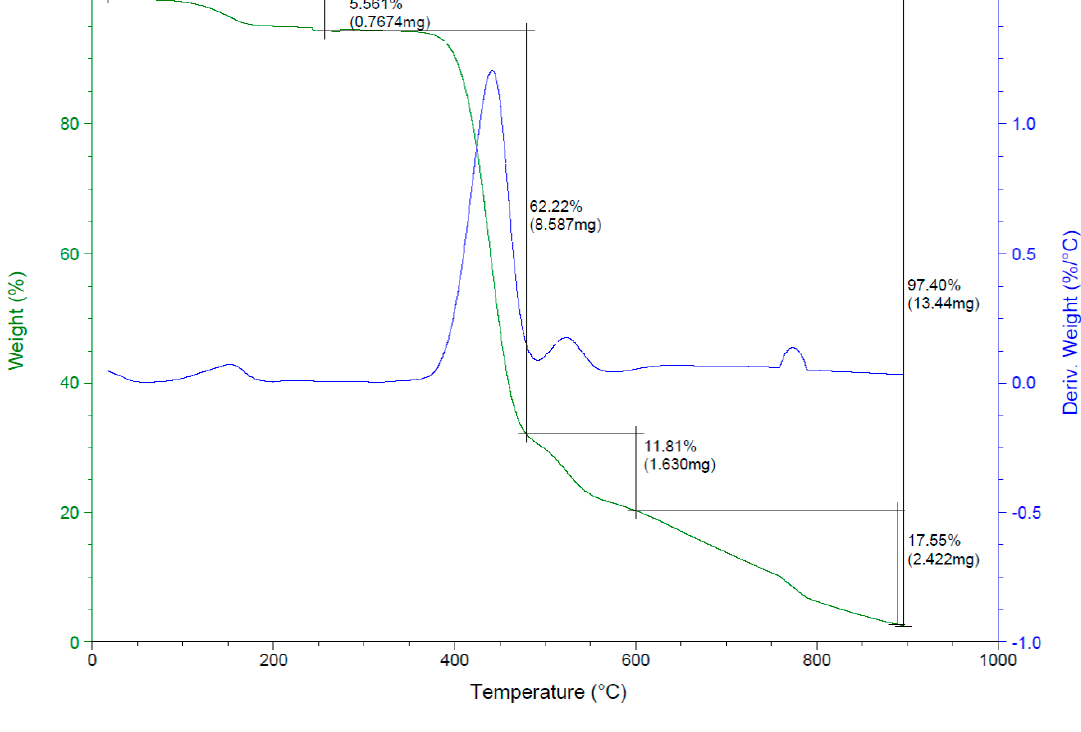
Figure 6. TGA for the reverse osmosis membrane.